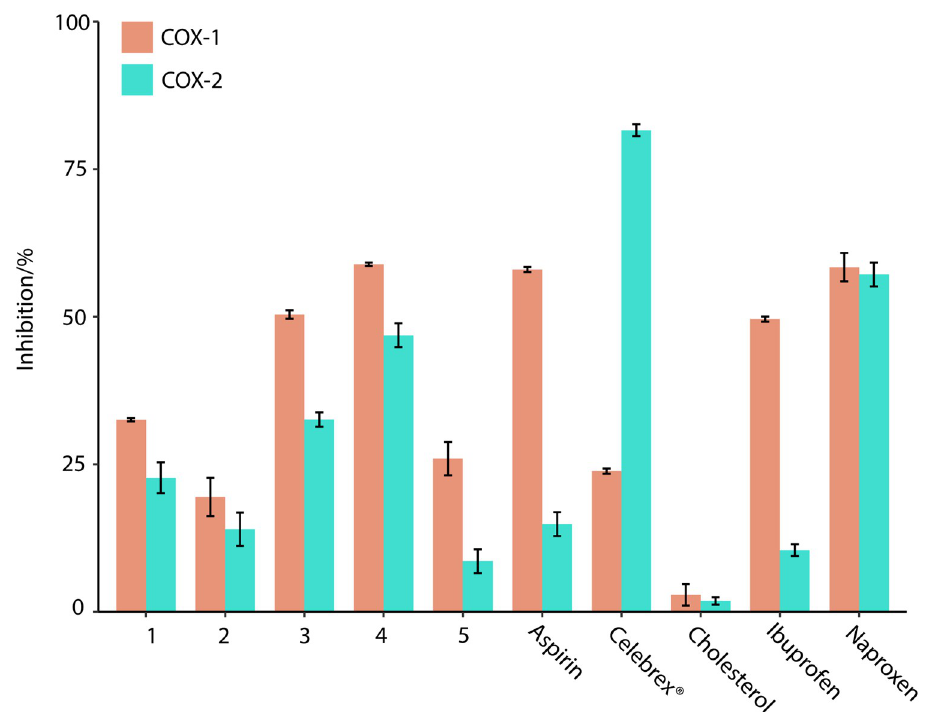
Fig 2. Cyclooxygenase enzymes (COX-1 and -2) enzyme inhibitory activities sterols (1–5) from the hexane extract of L . japonica and cholesterol were tested at 25 μ g/mL concentration. Commercial NSAIDs aspirin, ibuprofen, Celebrex 1 and naproxen used as positive control and tested at 108, 12, 1 and 12 μ g/mL, respectively. The varying concentrations of positive controls used were to yield a comparable activity profile between 50–100% by test compounds and positive controls alike. Vertical bars represent the standard deviation of each data point (n =